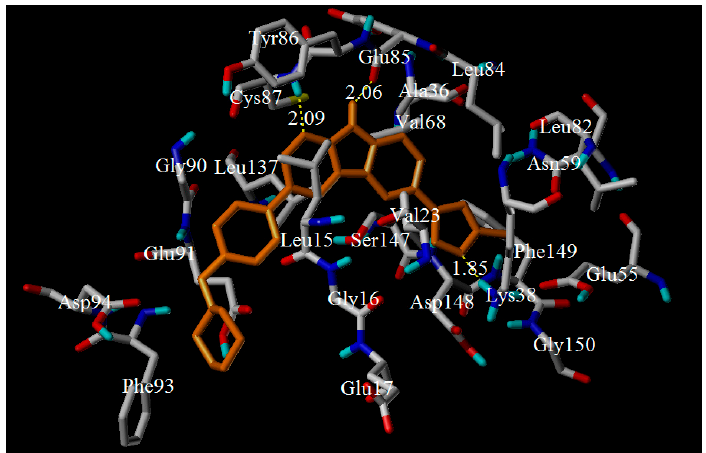
Figure 9. Docking result of compound 28 in the activity site of Chk1 protein. Ligand (yellow) and the key residues colored white for binding interaction were shown as stick model. The hydrogen-bonds were described as yellow lines, with distance unit of Å